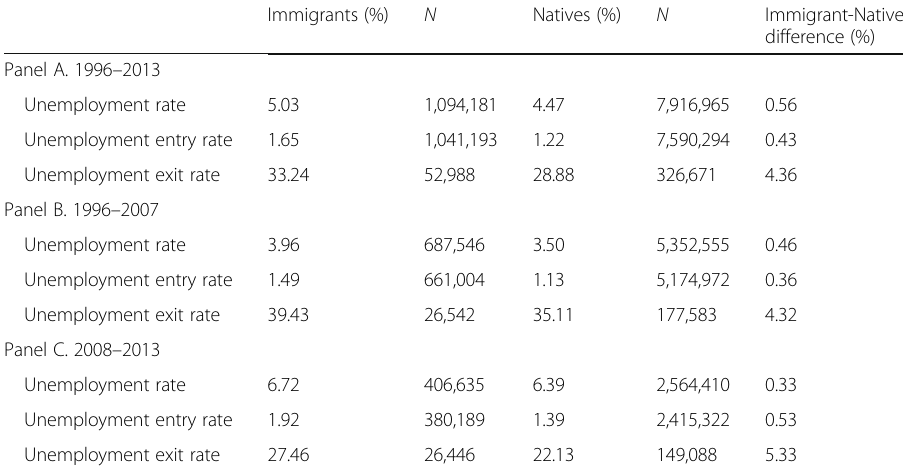
Table 2 Unemployment and transition rates, matched CPS data Immigrants (%) N Natives (%) N Immigrant-Native